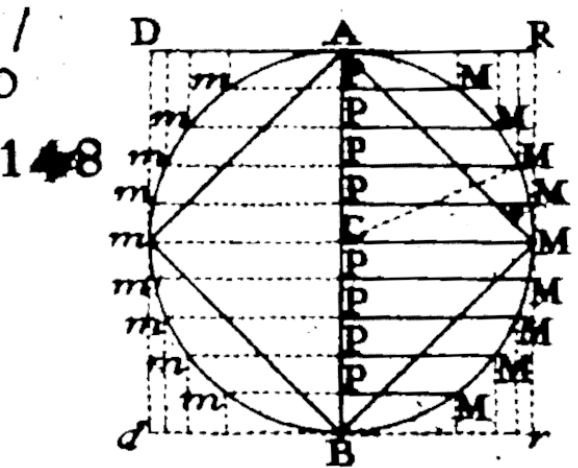
Figure 5. Graphical representation accompanying proposition 902. Source: García [57] (Plate I).